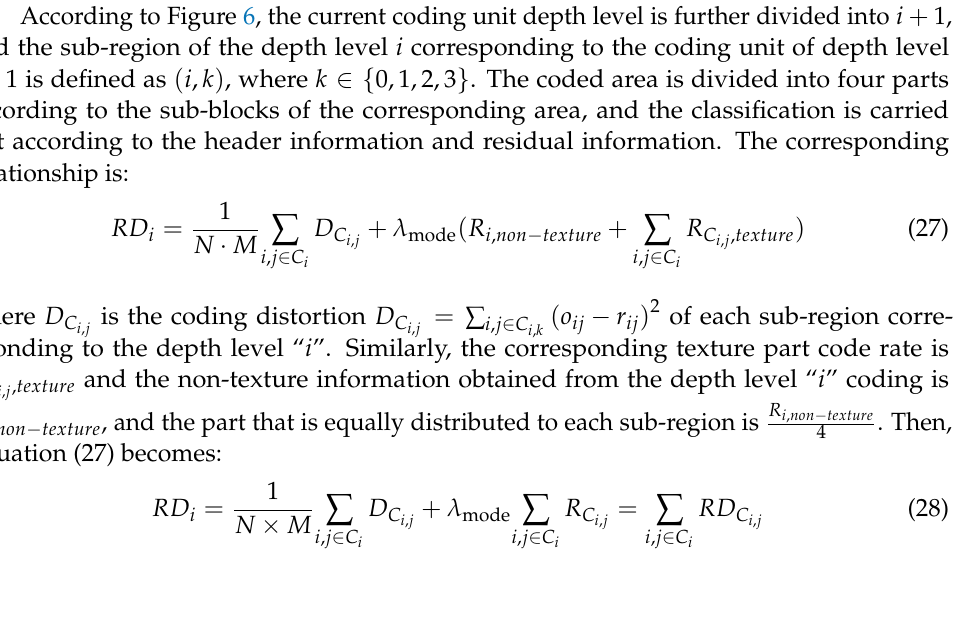
Figure 6. The flowchart of the proposed fast CU size decision algorithm.